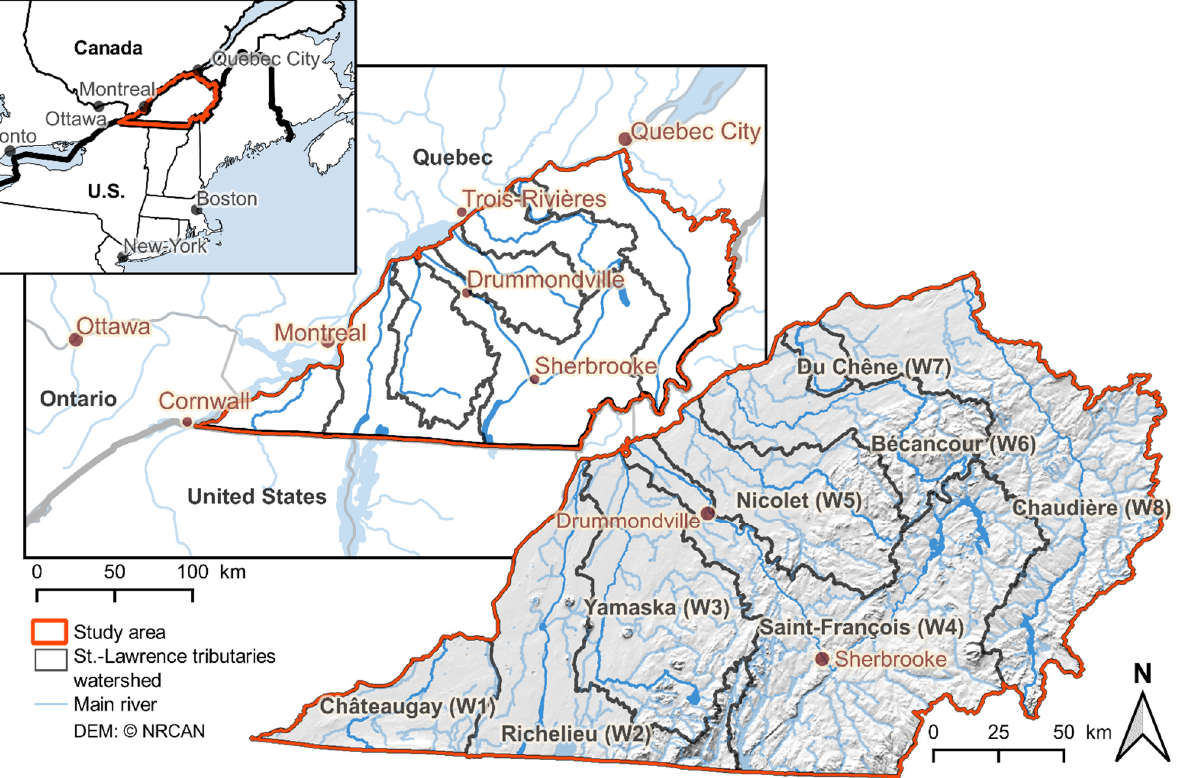
Figure 1. Location of the study area and the watersheds within.